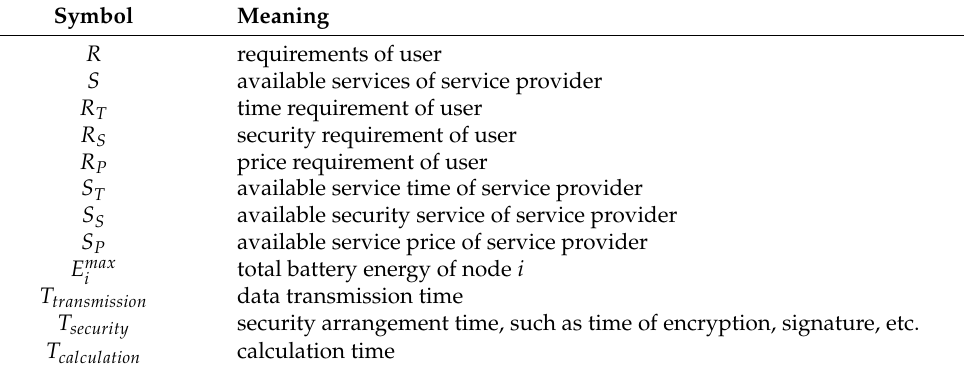
Table 2. List of main